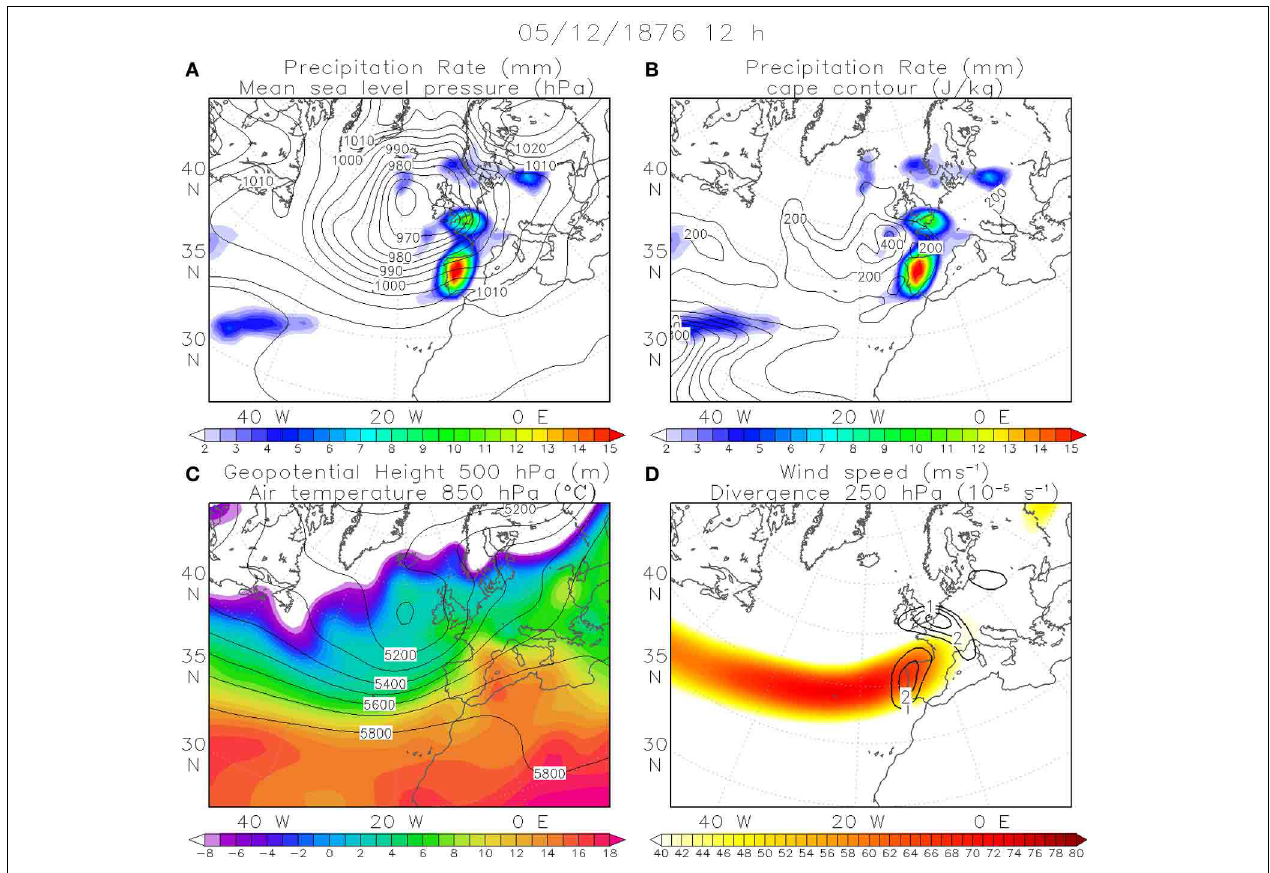
geopotential height at 500hPa (m, contours) and air temperature ( ◦ C, colors) 850hPa, (D) wind speed intensity (colors, ms − 1 ) and divergence (solid) and convergence (dotted) contours at